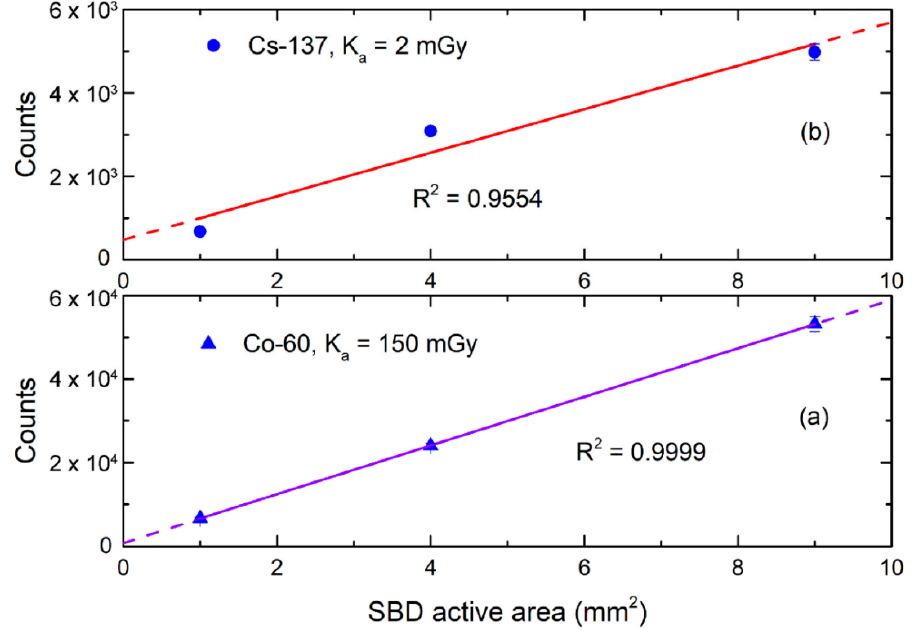
Figure 12. Response of three different 4H-SiC SBDs (1 mm 2 , 4 mm 2 , and 9 mm 2 areas) to gamma sources of Cs-137 ( a ) and Co-60 ( b ). The solid line shows linear fit for three 4H-SiC SBDs. Data reproduced from Ref. [9].